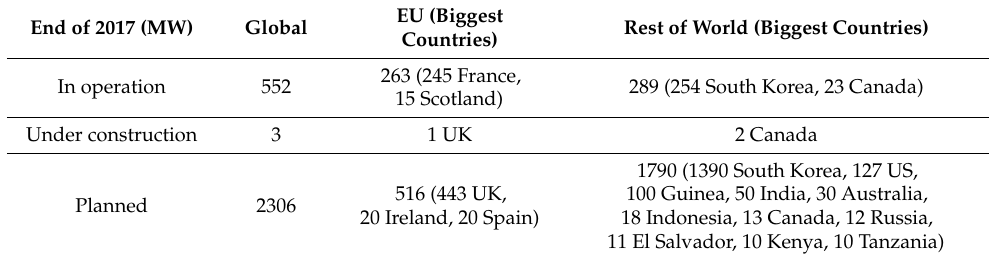
Table 5. Installed wave and tidal power plants (based on [49]).